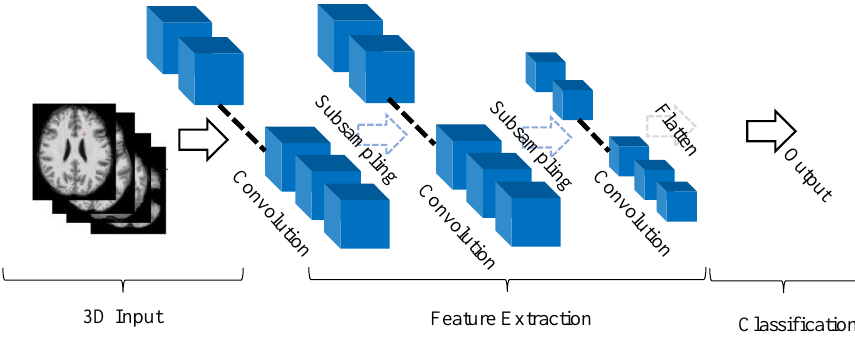
Figure 2. Criteria for literature selection for systematic review according to preferred reporting items for systematic seviews and meta-analyses (PRISMA) [23] guidelines.